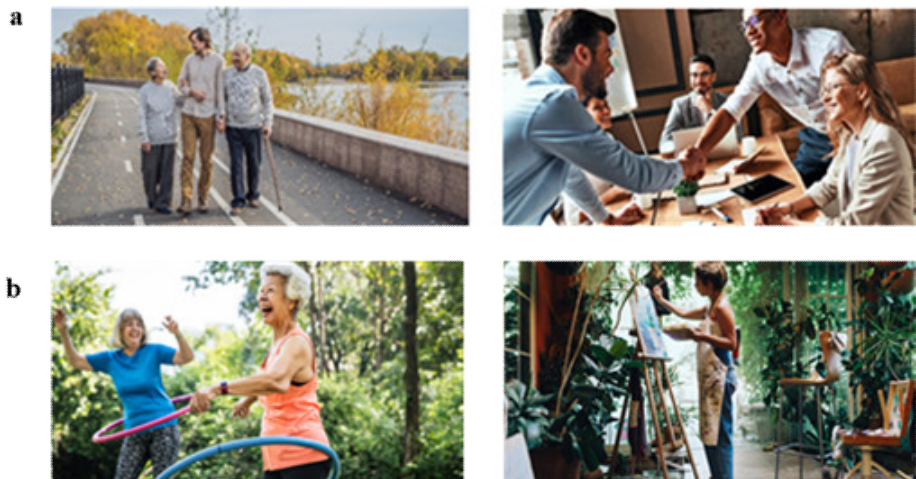
Figure 3. Examples of mixed-trait image pairs. ( a ) is designed to map onto the “I love to help others” statement from the altruism facet of agreeableness ( left ) and the “I feel comfortable around others” statement from the friendliness facet of extraversion ( right ). ( b ) is designed to be mapped onto the “I act comfortably around others” statement from the friendliness facet of extraversion ( left ) and “I believe in the importance of art” statement from the artistic interests facet of openness ( right